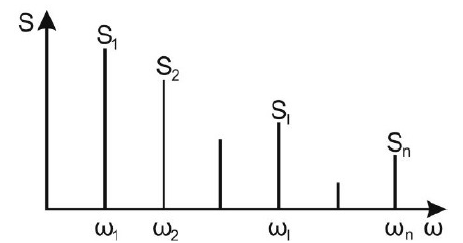
Figure 6. The amplitude spectrum of a periodic